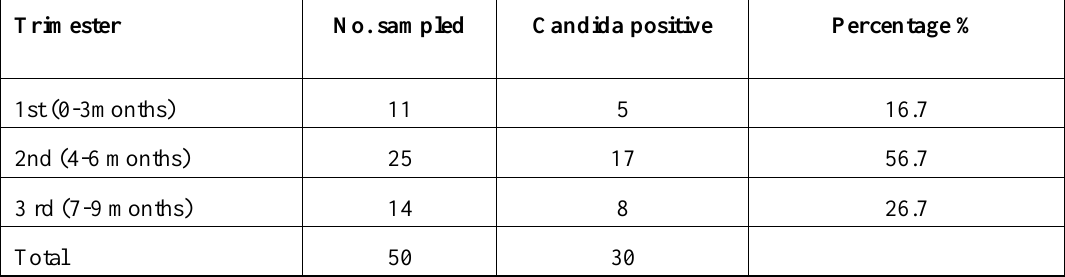
Table 3. Frequency distribution of C. albican among pregnant women of different trimester.